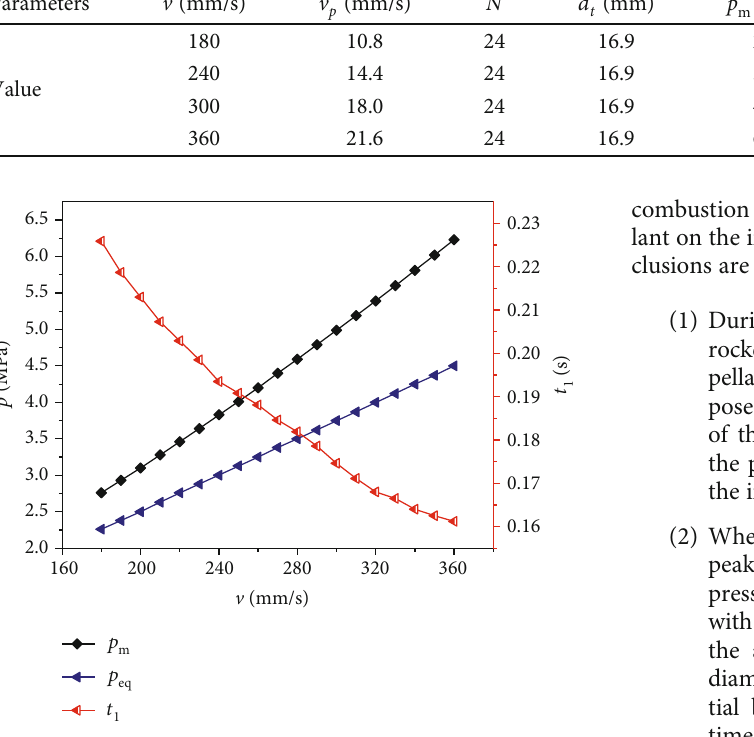
Figure 14: The pressure spike, equilibrium pressure, and ignition transient for di ff erent fl ow velocities of the pasty propellant.